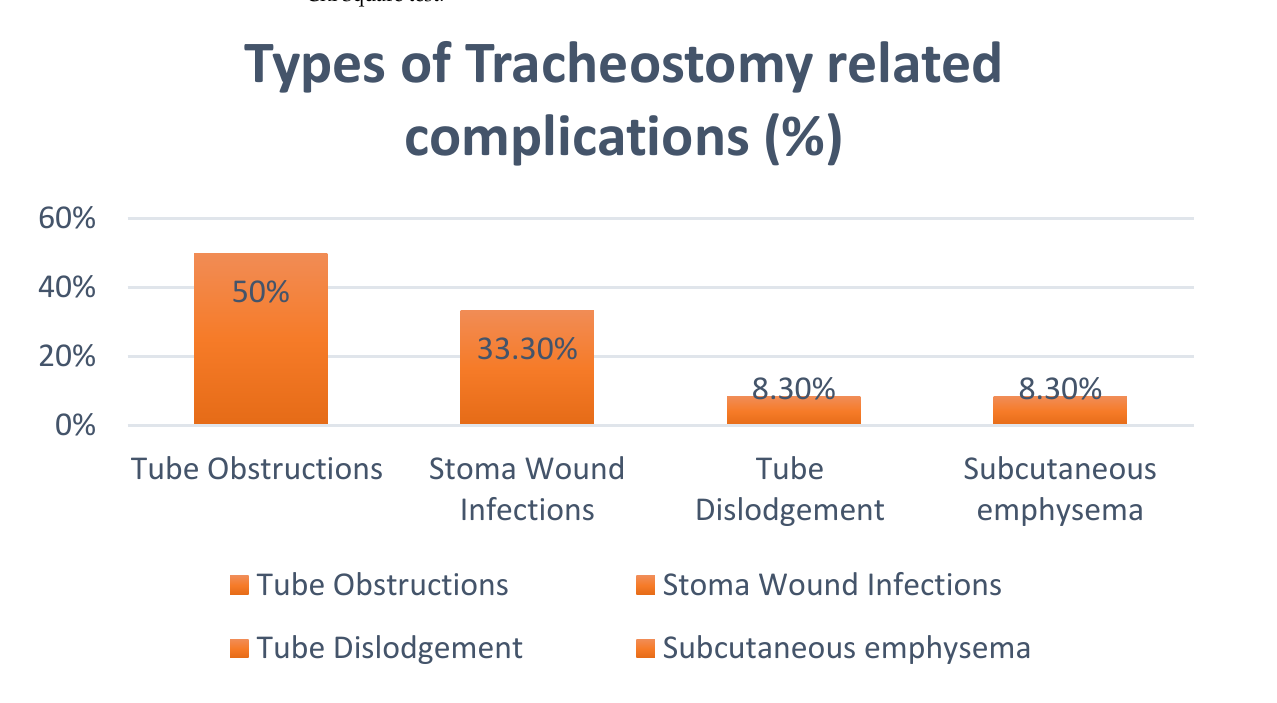
Figure 4. Types of tracheostomy-related complications.